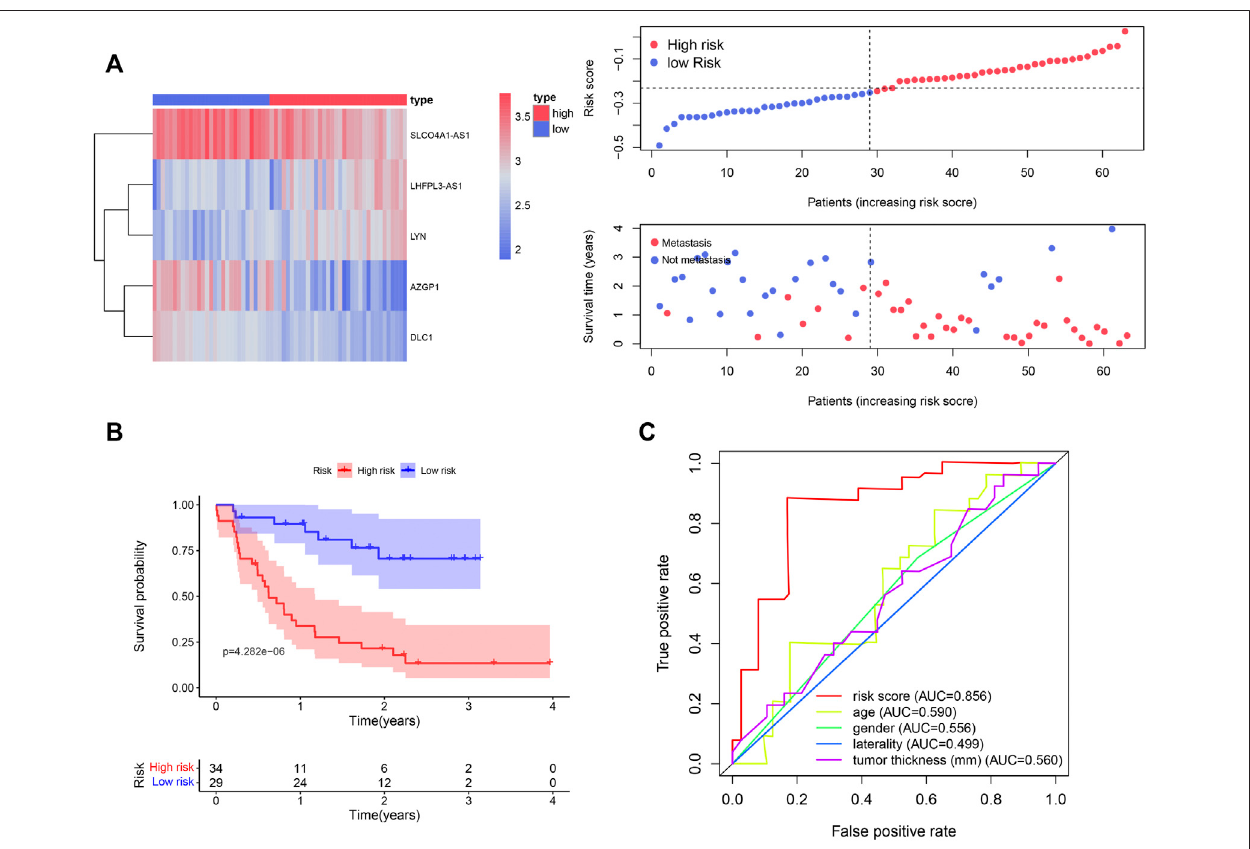
FIGURE 7 | Validation of the fi ve immune-related gene signature in the GSE22138 cohort. (A) A total of 63 UVM patients were divided into low- and high-risk subgroups based on the median cutoff risk score. The heatmap of gene expression, distribution of risk score and survival status between the two groups were shown. (B) Kaplan – Meier curve of UVM patients in the low- and high-risk groups. (C) ROC curves with calculated AUCs of the fi ve immune-related gene signature.